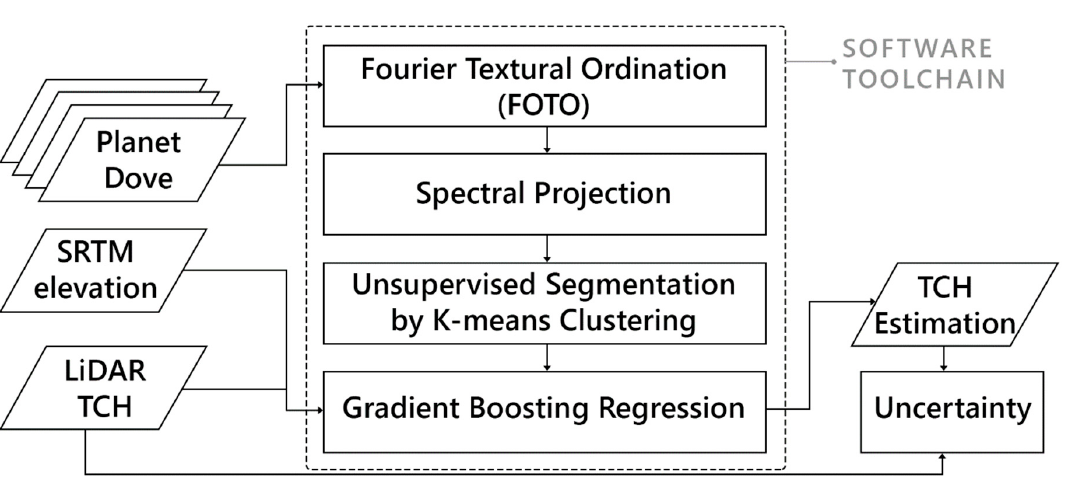
Figure 2. The workflow for TCH estimation using Planet Dove, elevation, and airborne LiDAR datasets. The Planet Dove high-resolution mosaic was used as input for the Fourier textural ordination (FOTO) and spectral projection in order to generate features for the gradient boosted regression model weighted based on K-means clusters. The final TCH estimation was validated against hold-out airborne LiDAR measurements of TCH.